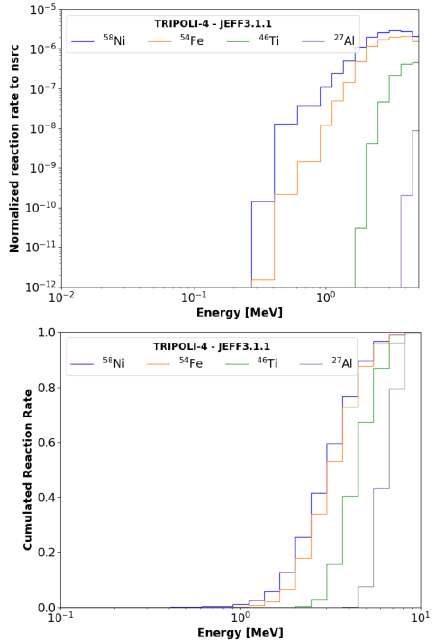
Fig. 4. Distribution of reaction rates and cumulated reaction rates for threshold dosimeters.